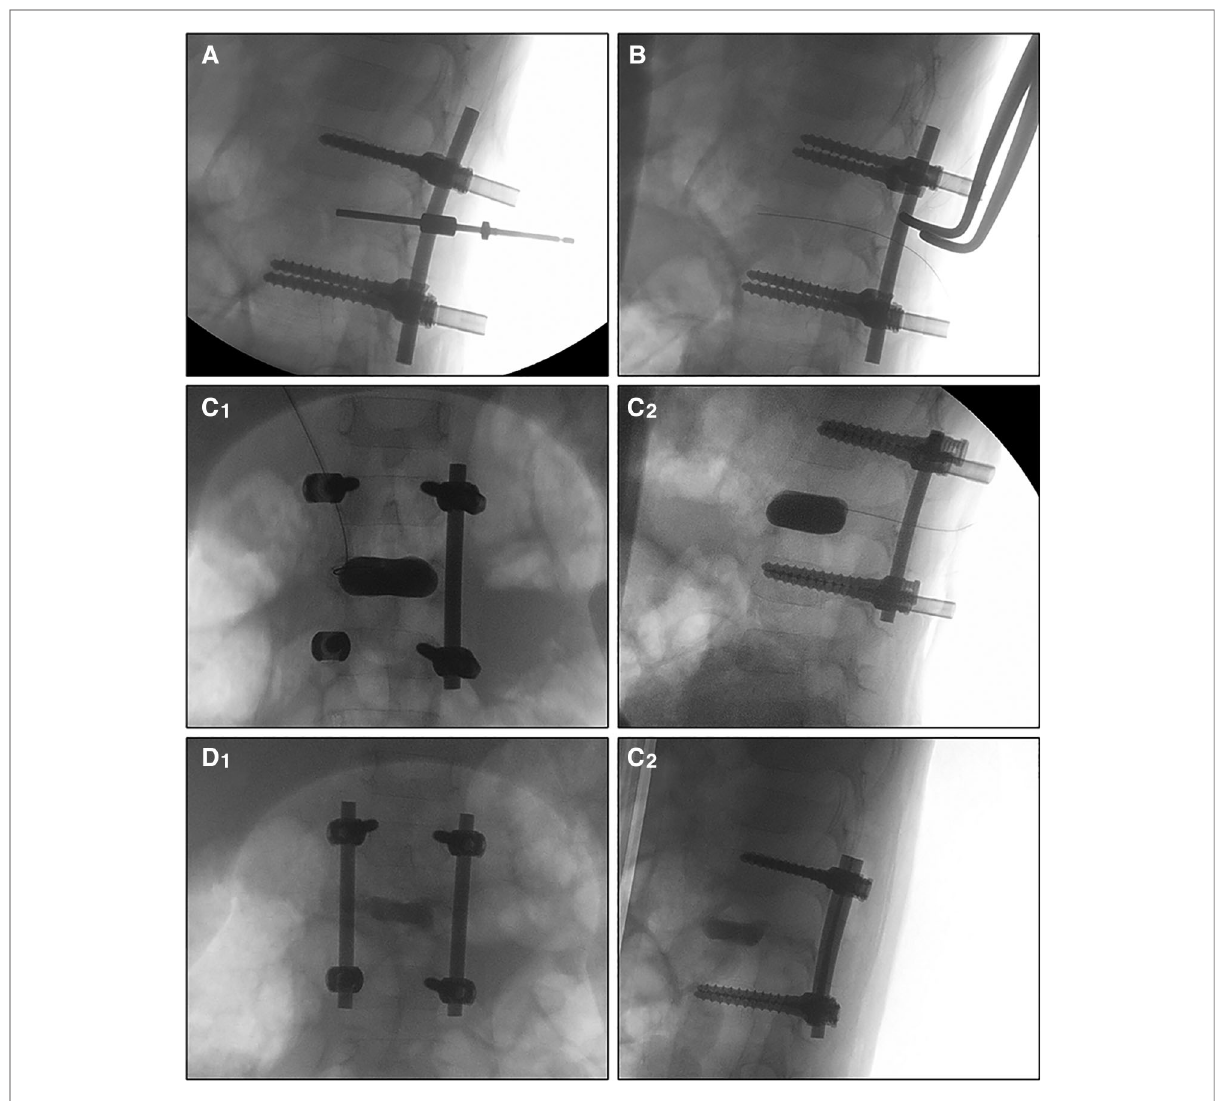
FIGURE 1 Fluoroscopy images during the operation. The work tunnel was created transpedicular ( A ), then the balloon was loaded into the vertebral body ( B ) after the lesion curettage and in fl ated simultaneously under fl uoroscopic guidance and pressure control (up to 120 psi) ( C1,C2 ). The void was fi lled with calcium sulfate cement and then the rods were locked ( D1,D2 ).